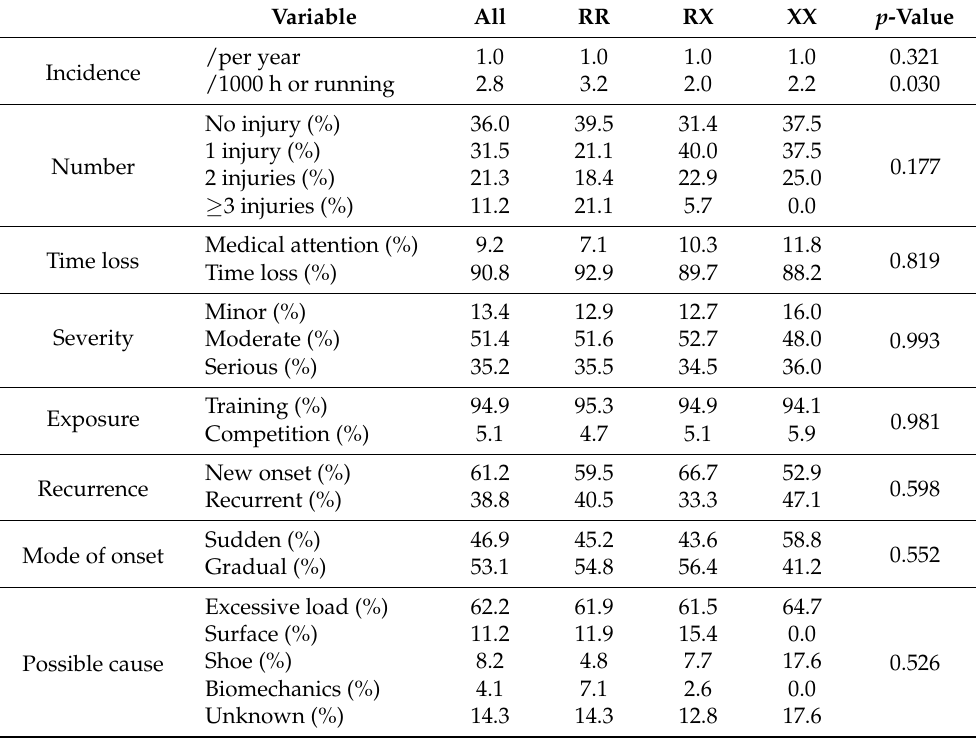
Table 3. Injury incidence, distribution of athletes according to the number of injuries, and distribution of injuries according to severity, exposure, recurrence, mode of onset, and possible cause in elite endurance runners with different ACTN3 R577X genotypes. Variable All Incidence